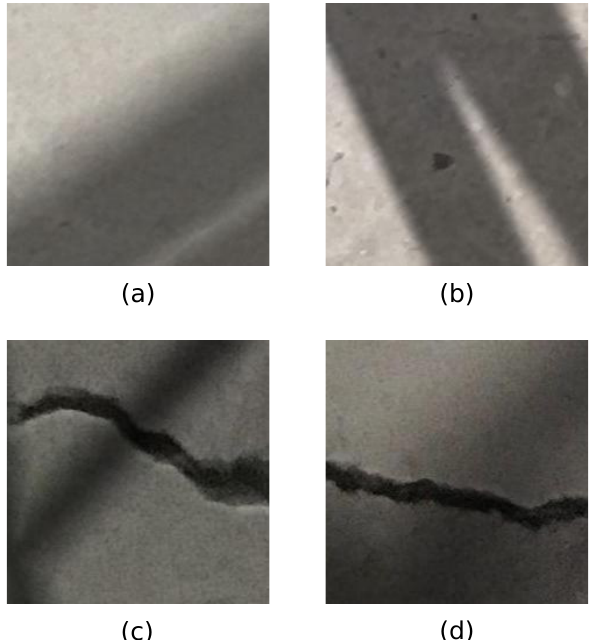
Figure 5. Typical images after the application of shadow augmentation technique for images in Mendeley Concrete Crack Images for Classification data set: ( a , b ) depicts images without cracks; ( c , d ) depicts images with